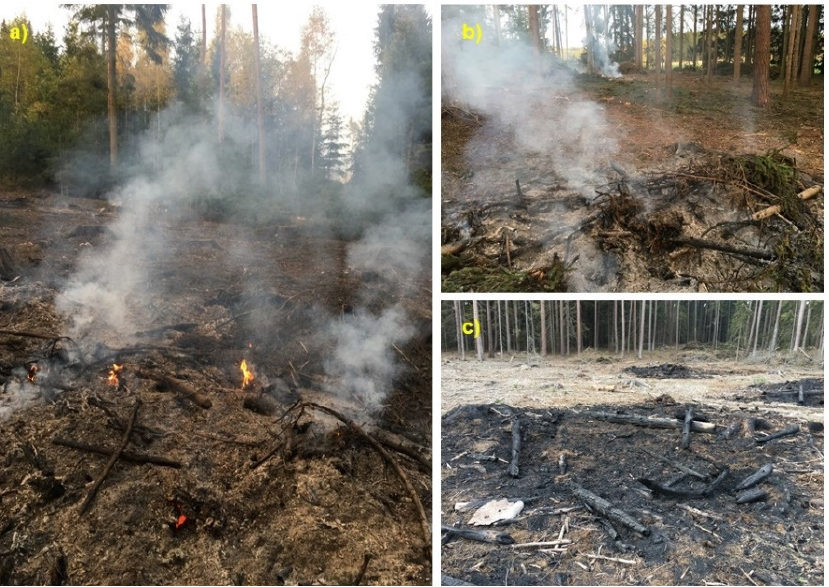
Figure 1. ( a ) Pile burning of slashed woods; ( b ) smoldering fires; ( c ) aftermath of the pile burning.